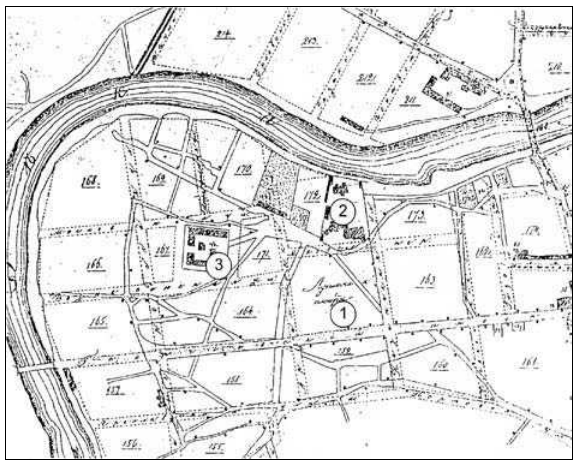
Fig. 1. Fragment of Vilnius Plan at the beginning of